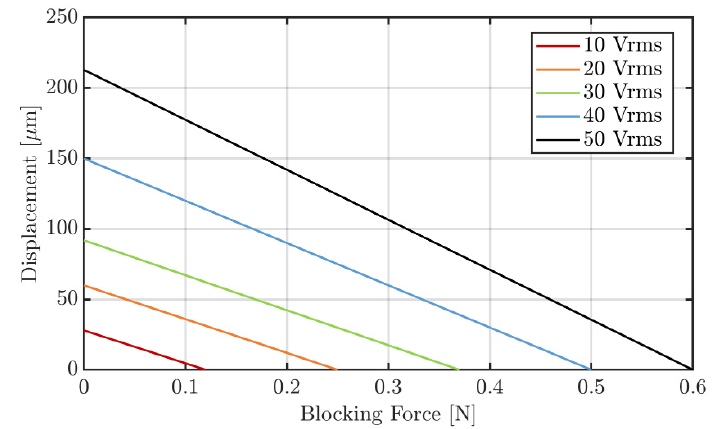
Figure 9. Working graph of the transducer for different voltages, all five layers were active. It should be noticed, the blocking force and the out-of-plane displacement of the transducer were measured at ambient conditions where small changes in temperature and relative humidity may have occurred.